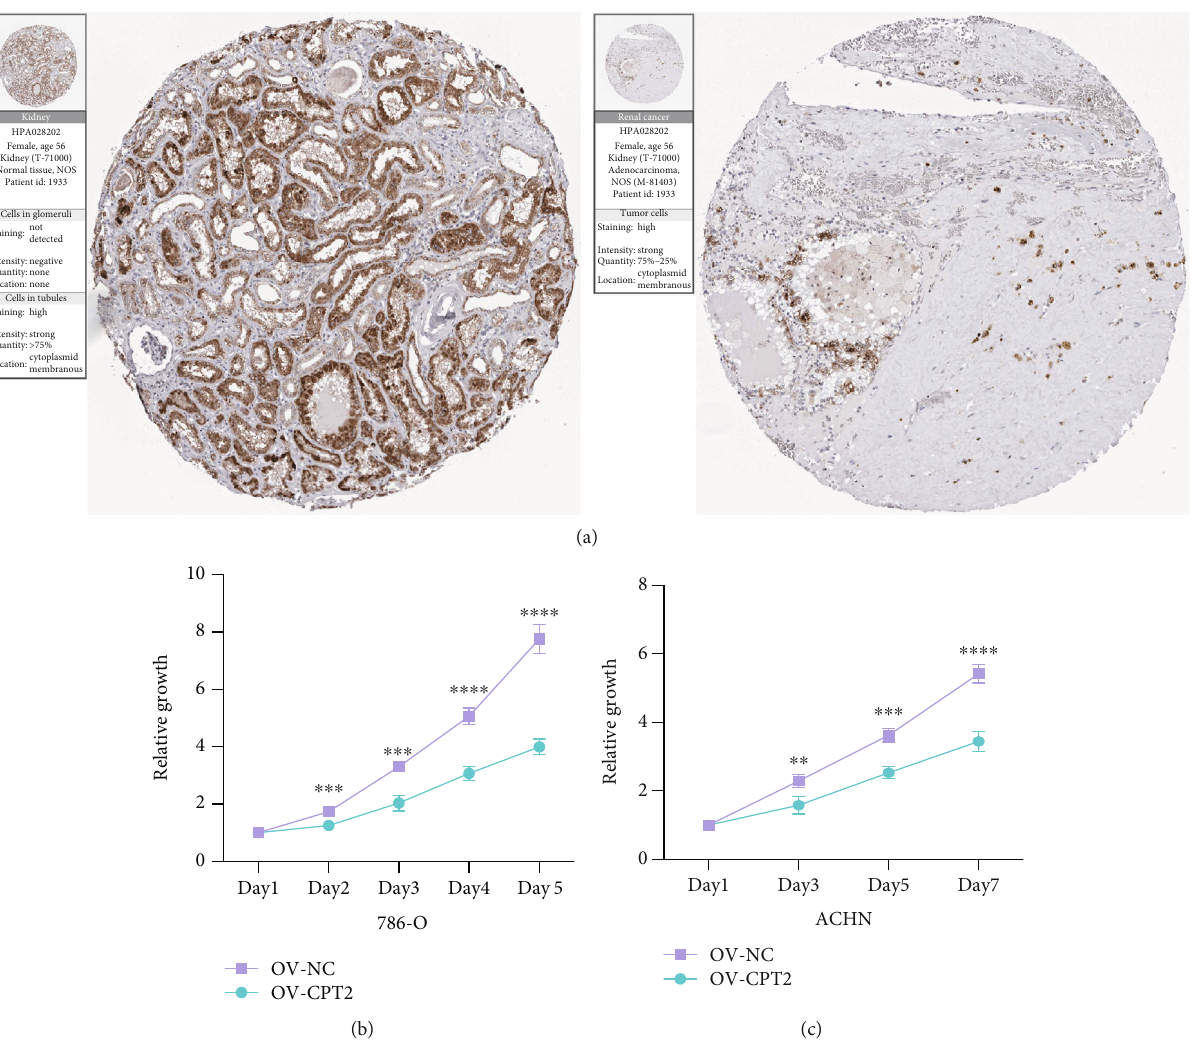
Figure 6: Experimental veri fi cation of CPT2. (a) Immunohistochemical images from the HPA database show CPT2 protein expression in normal kidney (N) and KIRC (T) tissues. (b, c) CCK8 assay results show the relative proliferation of OV-NC- and OV-CPT2-transfected 786-O and ACHN cell lines. The data are shown as mean ± S : D . ∗∗ P < 0 : 01 ; ∗∗∗ P < 0 : 001 ; ∗∗∗∗ P < 0 : 0001